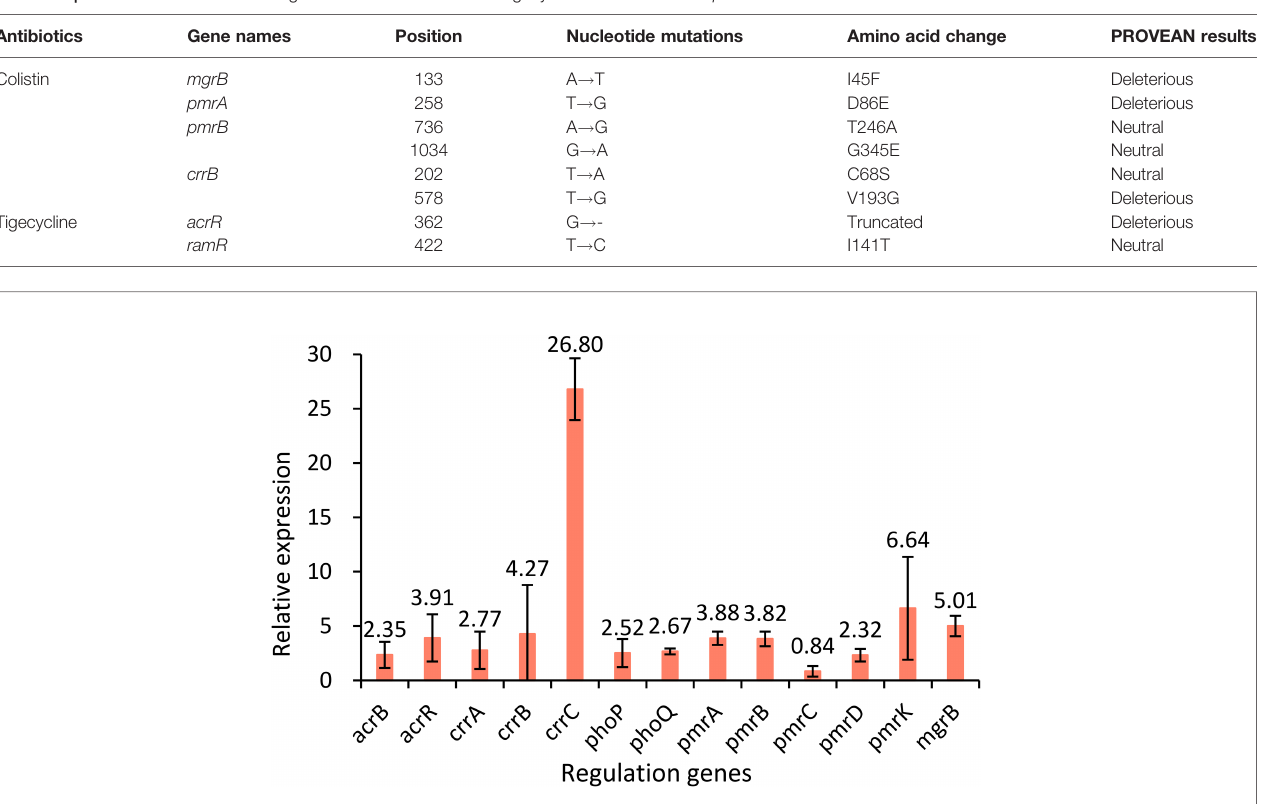
TABLE 2 | Mutations in chromosomal genes related to colistin and tigecycline resistance for K. pneumoniae KP32558. Antibiotics